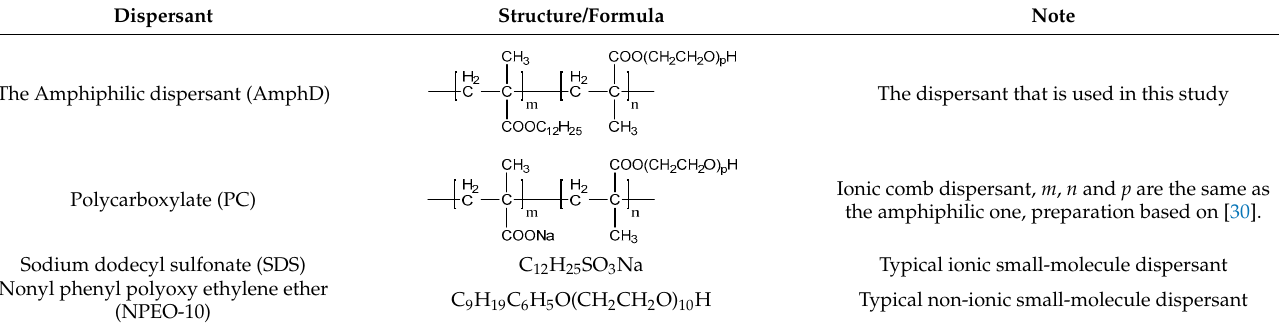
Table 2. Dispersants that were used in CC dispersion comparison